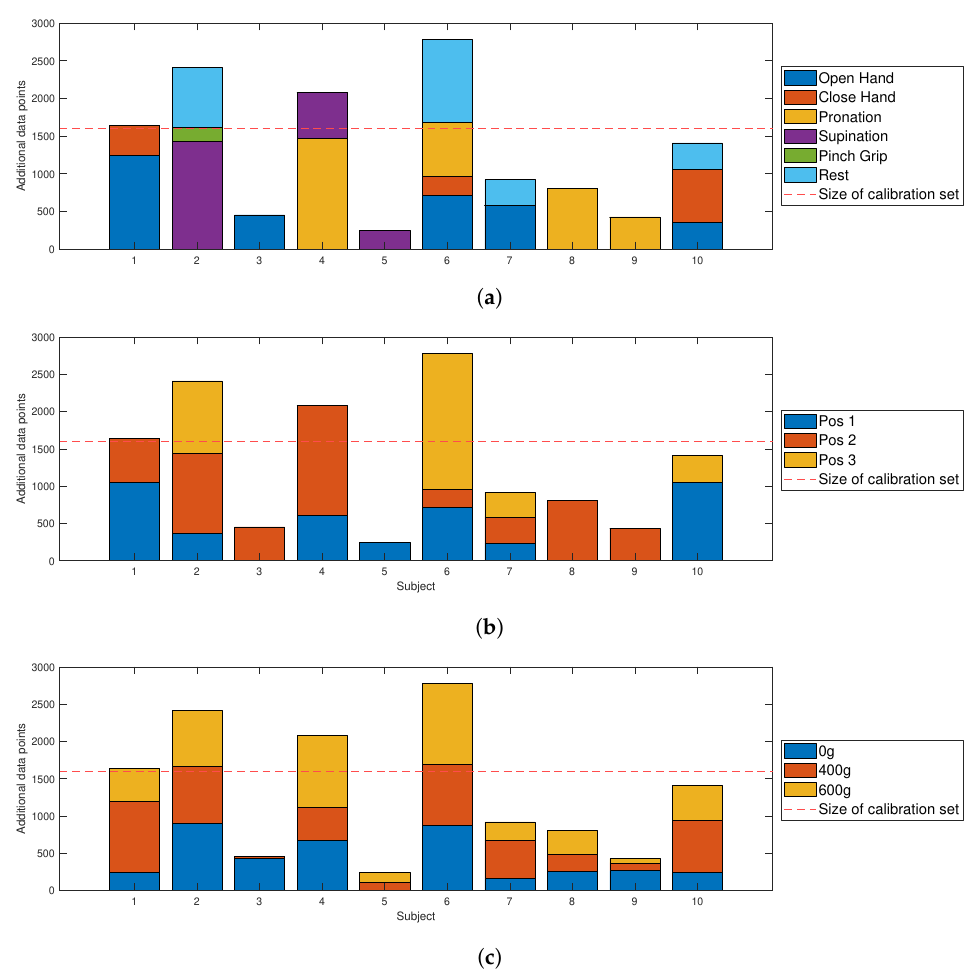
Figure 18. Amount and variation of sample points selected for calibration set adaptation. ( a ) Hand motion samples adapted per subject. ( b ) Limb position samples adapted per subject. ( c ) External load samples adapted per subject.